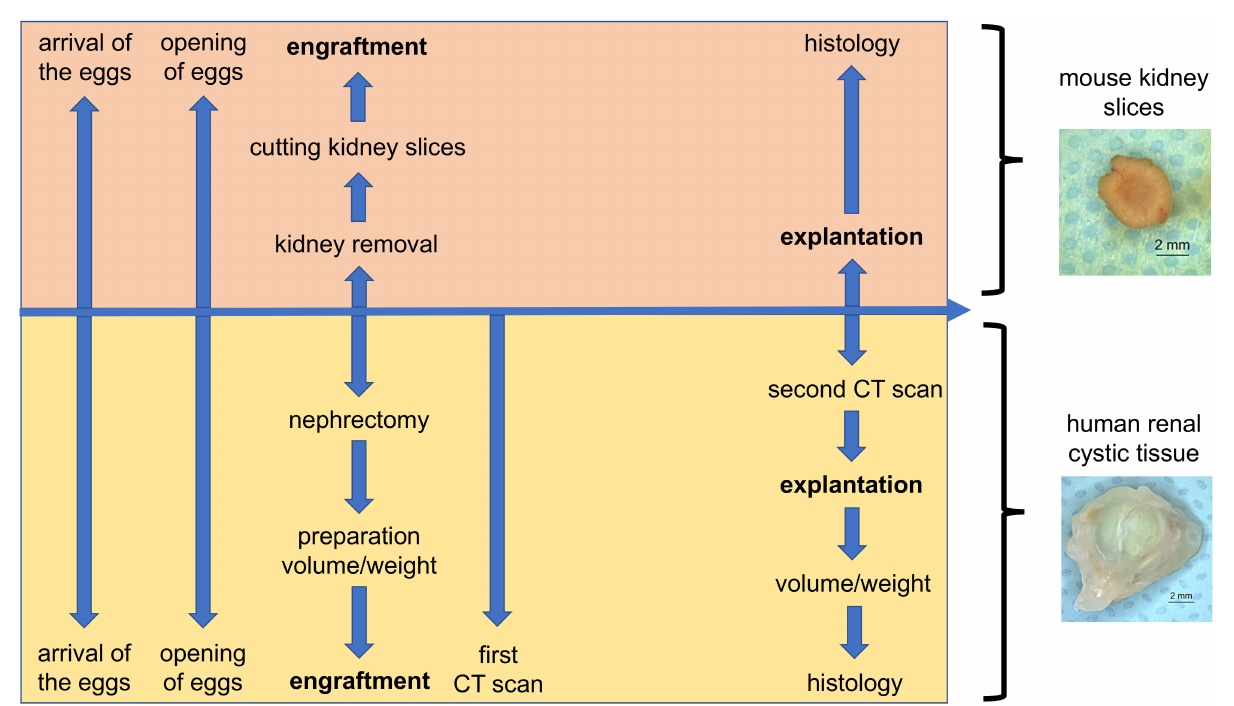
Figure 1. Schematic depiction of the chorioallantoic membrane (CAM) model protocol for the investigation of human renal cystic tissue and mouse kidney